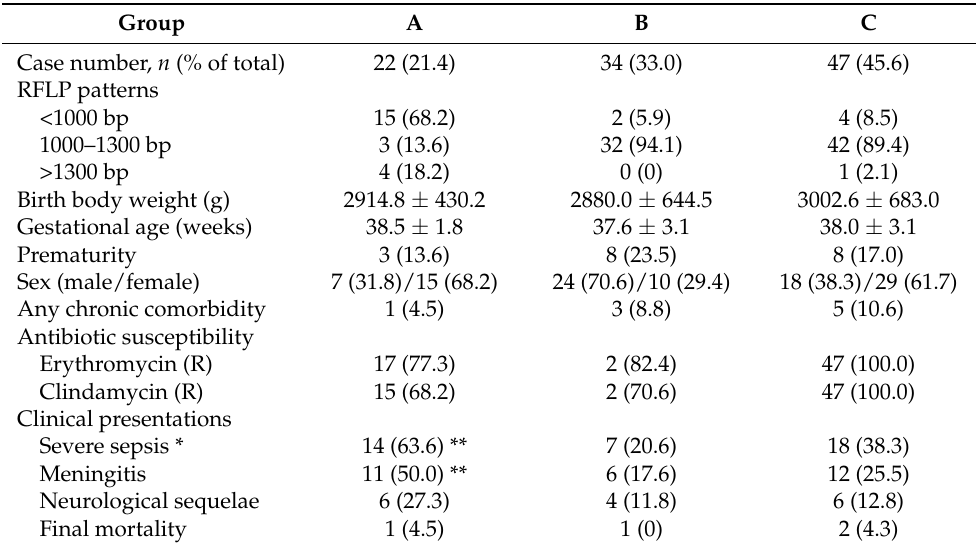
Table 2. Clinical presentations of 103 cases of GBS invasive diseases categorized based on the length of the CRISPR-RFLP array and eBURST analysis.